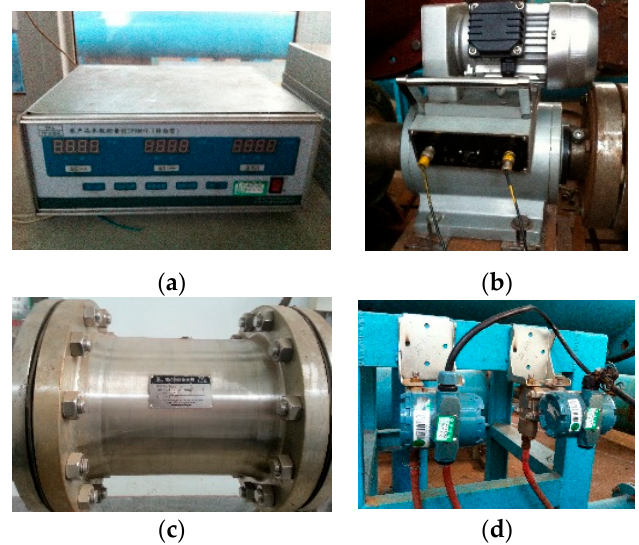
Figure 8. Measuring instruments: ( a ) data collector, ( b ) torque speed sensor, ( c ) flowmeter and ( d ) pressure sensor.